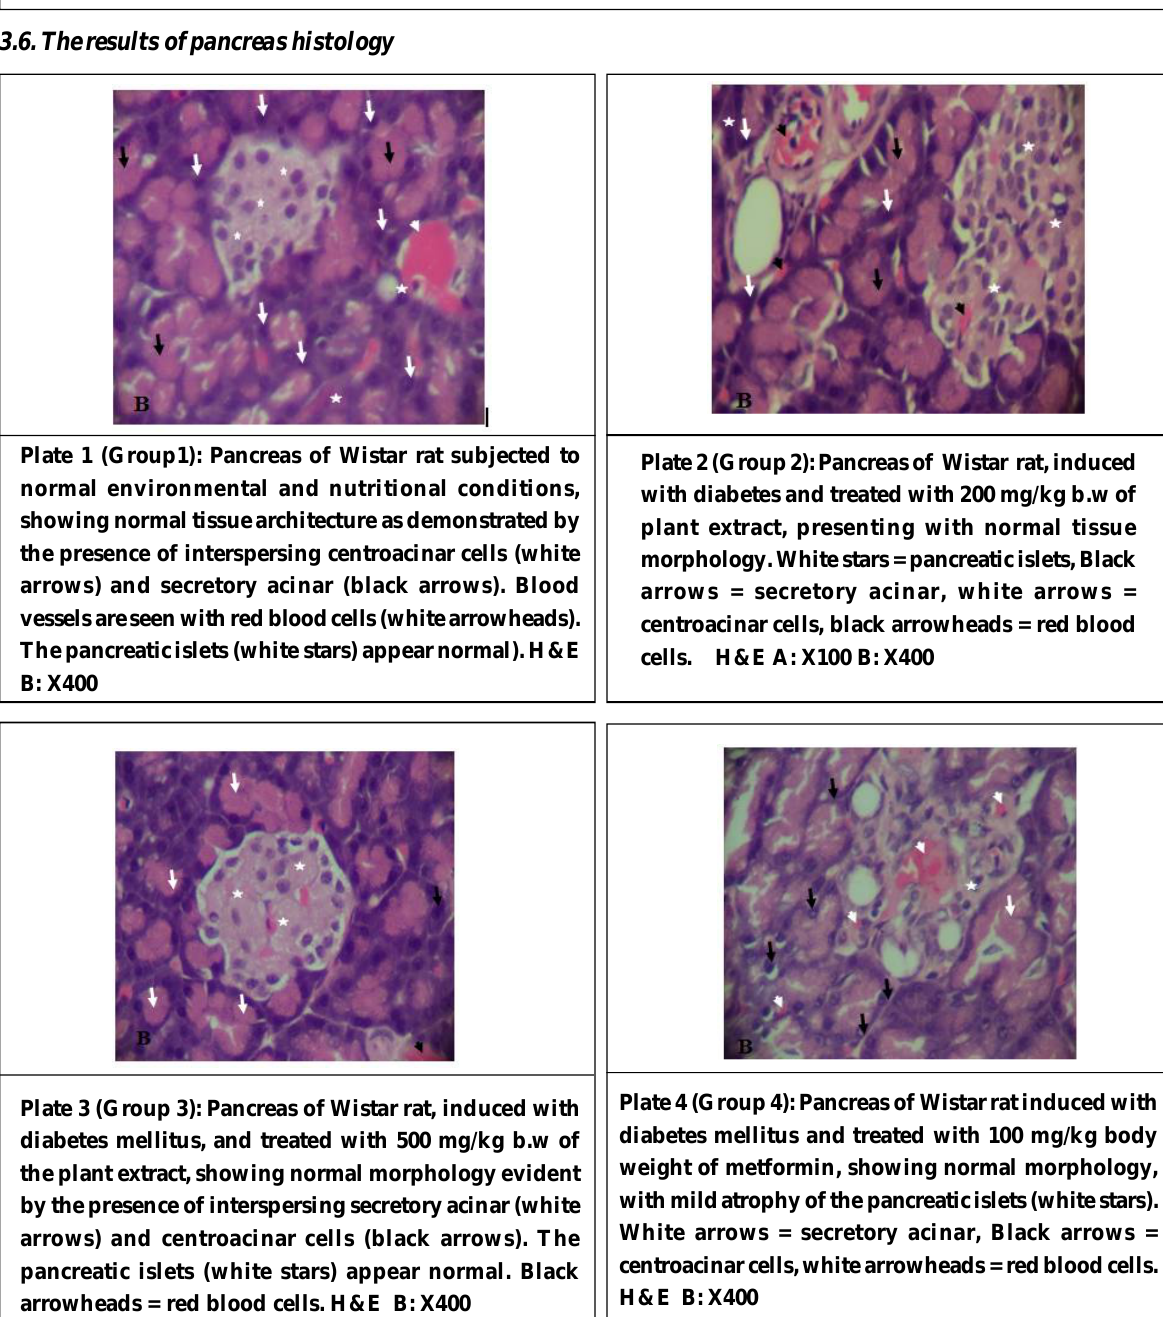
Plate 4 (Group 4): Pancreas of Wistar rat induced with diabetes mellitus and treated with 100 mg/kg body weight of metformin, showing normal morphology, with mild atrophy of the pancreatic islets (white stars). White arrows = secretory acinar, Black arrows = centroacinar cells, white arrowheads = red blood cells. H&E B: